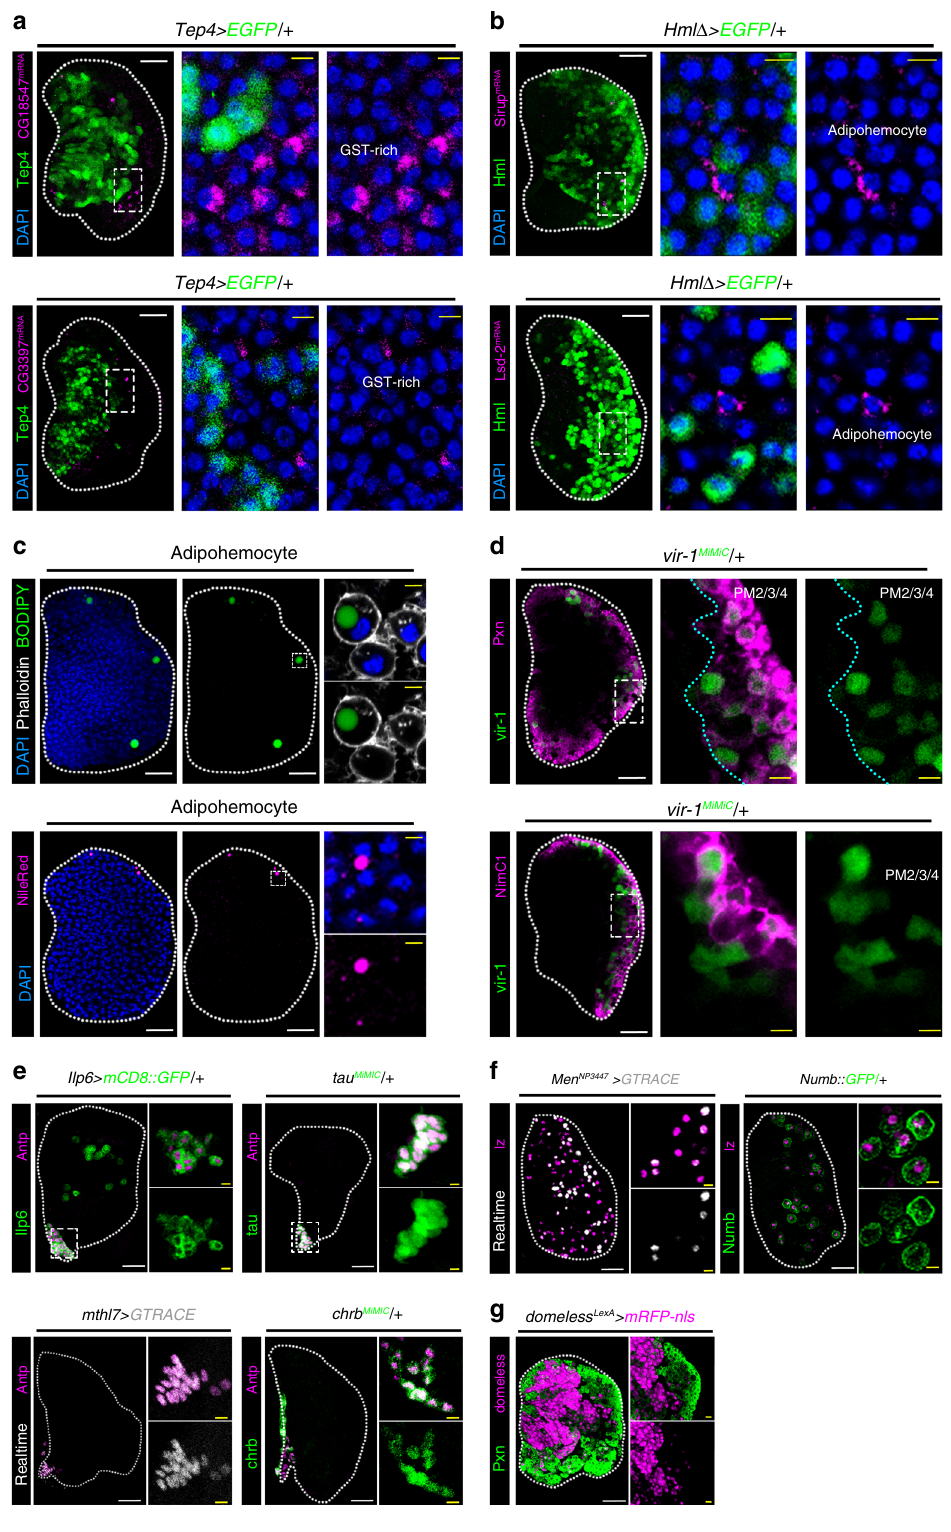
subclusters. mRNA transcripts of CG18547 or CG3397 ,